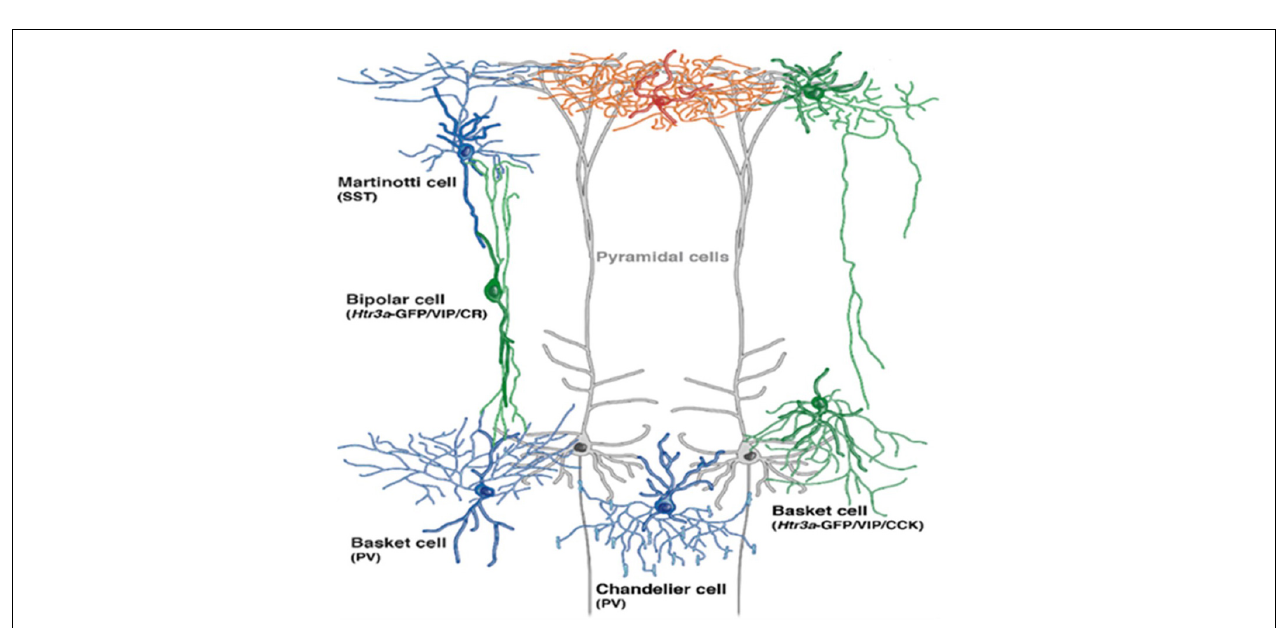
FIGURE 1 | Illustration of γ -amino butyric acid (GABA) synthesis, transmission, and reuptake from synaptic cleft.